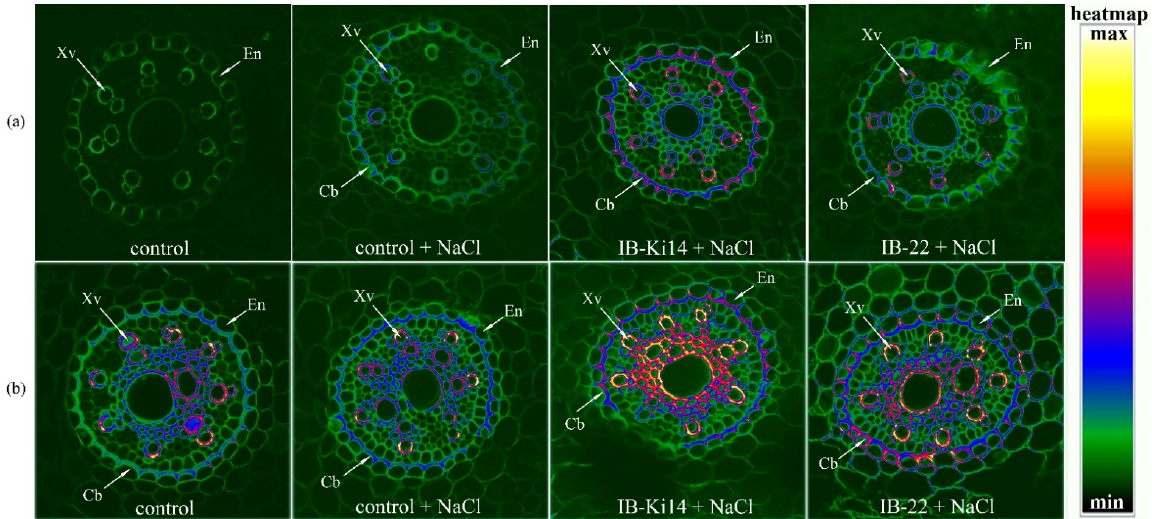
Figure 1. Localization of lignin and suberin and detection of Casparian bands in berberine ‐ stained root cross ‐ sections of the 6 ‐ day ‐ old ( a ) and 11 ‐ day ‐ old ( b ) wheat plants treated with NaCl and bac ‐ stained root cross-sections of the 6-day-old ( a ) and 11-day-old ( b ) wheat plants treated with NaCl terial strains ( Pseudomonas mandelii IB ‐ Ki14 (IB ‐ Ki14) and Bacillus subtilis IB ‐ 22 (IB ‐ 22)). Cb—Caspar ‐ ian bands, En—endoderm, Xv—xylem vessels. The heatmap shows color ‐ coded fluorescence signal and bacterial strains ( Pseudomonas mandelii IB-Ki14 (IB-Ki14) and Bacillus subtilis IB-22 (IB-22)). intensities. Cb—Casparian bands, En—endoderm, Xv—xylem vessels. The heatmap shows color-coded flu- orescence signal